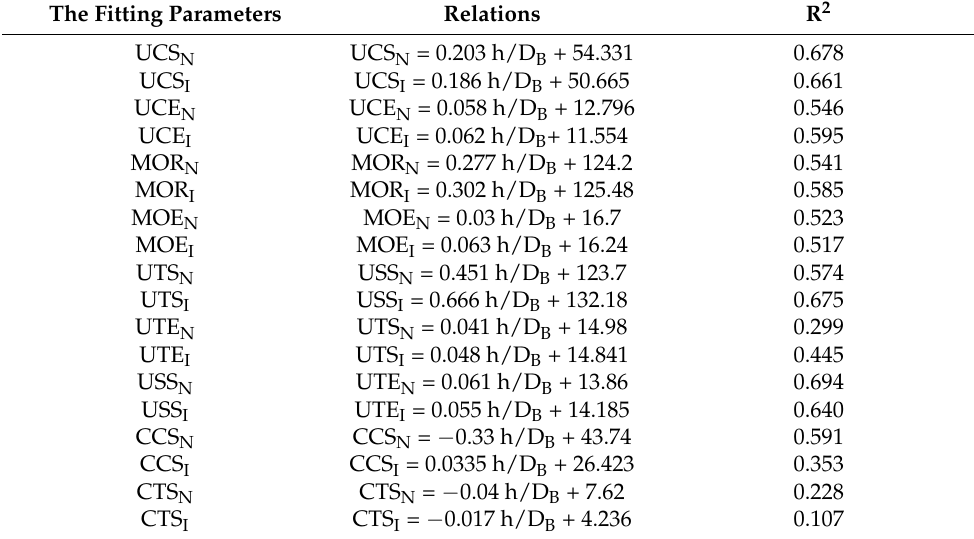
Table 3. Relationship between the physical and mechanical properties and h/D B .